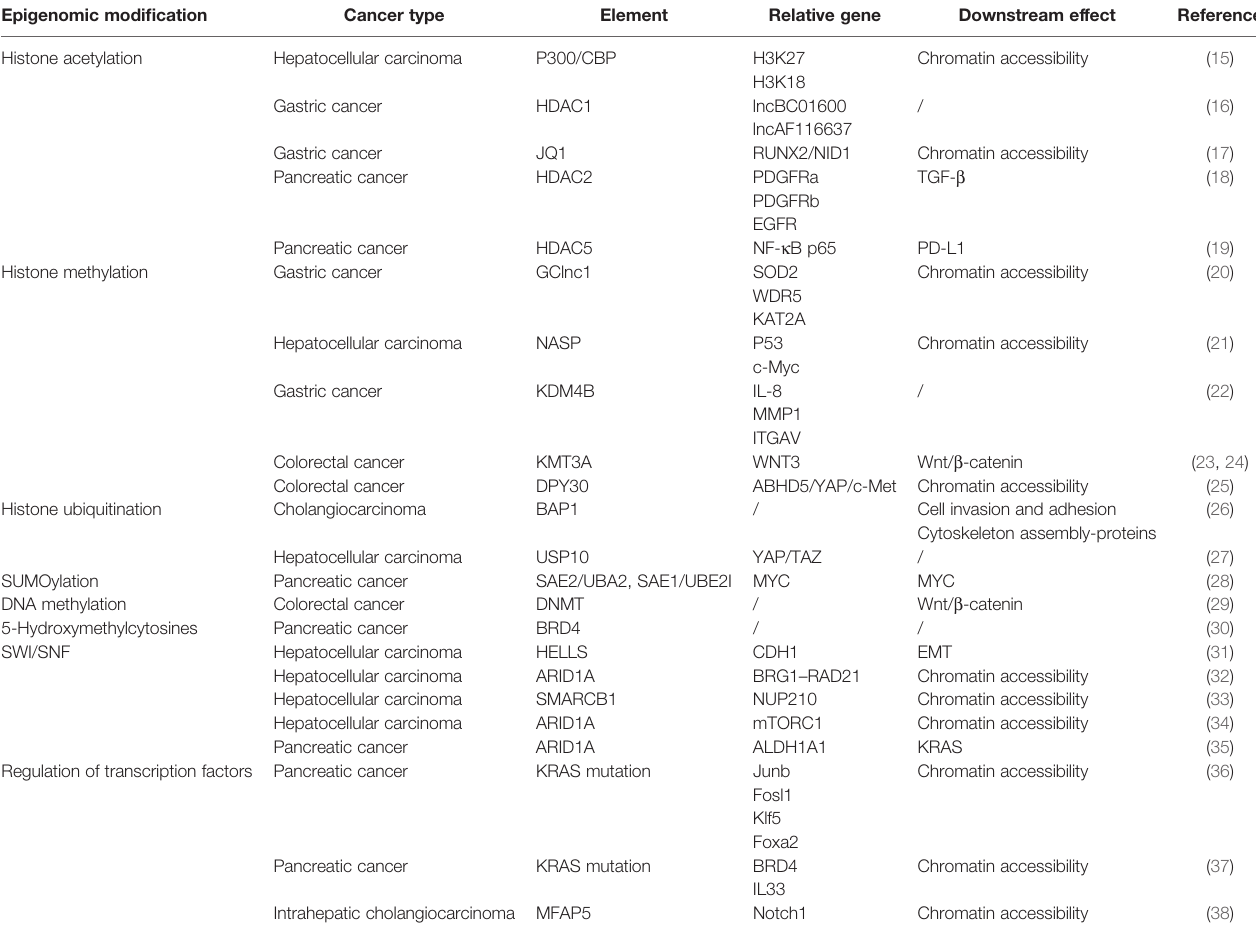
TABLE 1 | Chromatin regulation and relative pathways in digestive system